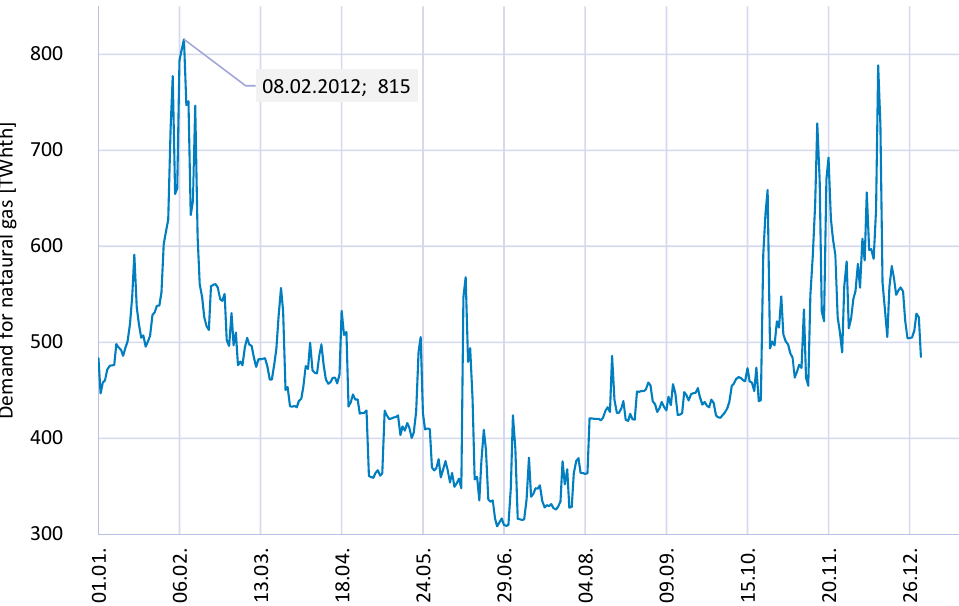
Figure 6. Results of JMM for the simulated daily consumption of natural gas in the German electricity sector for January-March 2012.